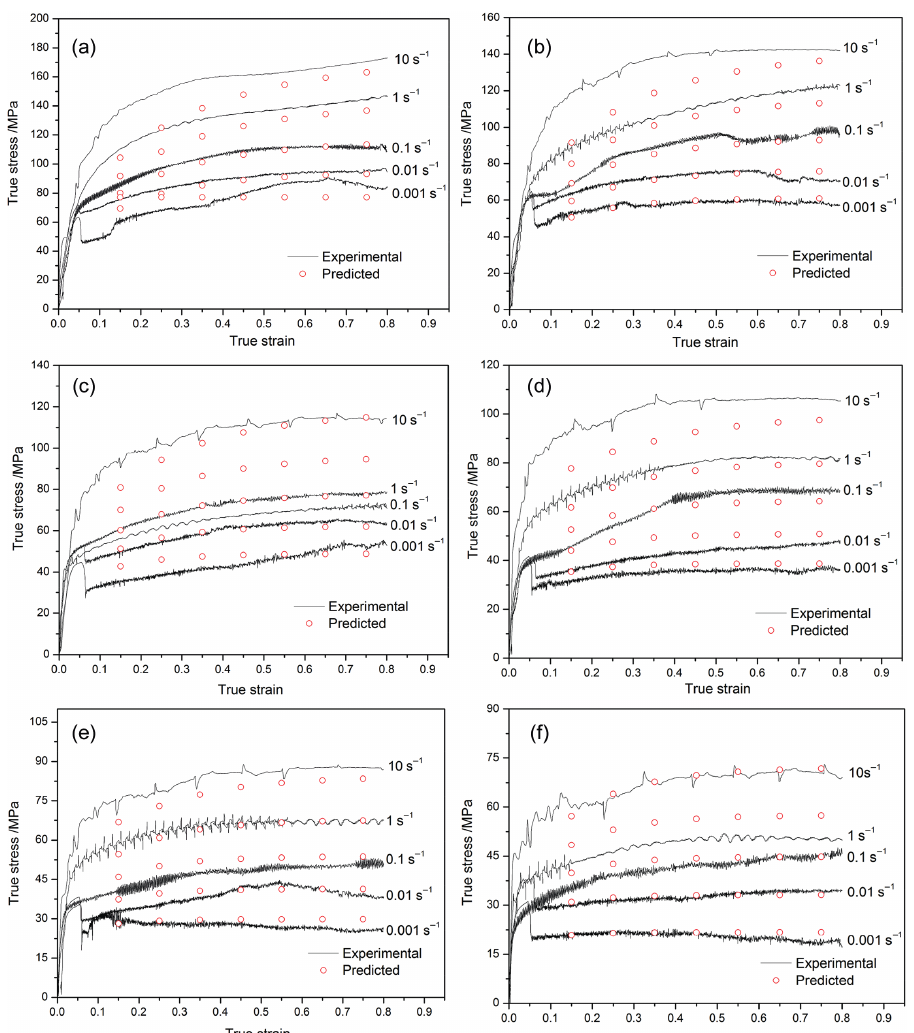
Figure 10: Comparison between the experimental and predicted flow stress at the temperature of: (a) 1,023 K, (b) 1,073 K, (c) 1,123 K, (d) 1,173 K, (e) 1,223K, (f) 1,273